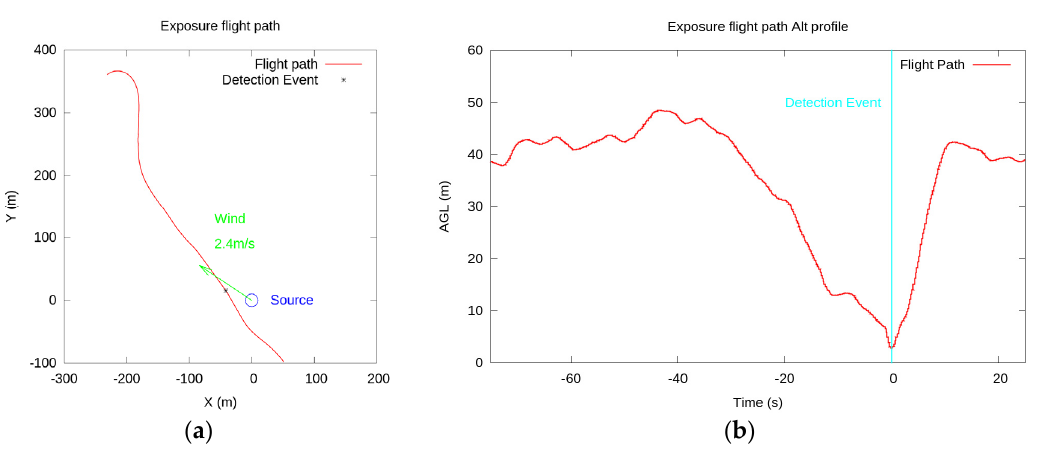
Figure 7. UAV flight trajectory during EFT. ( a ) Aircraft travelling southeast upwind into the vapour cloud; and ( b ) Aircraft altitude profile during approach. Detection event marked